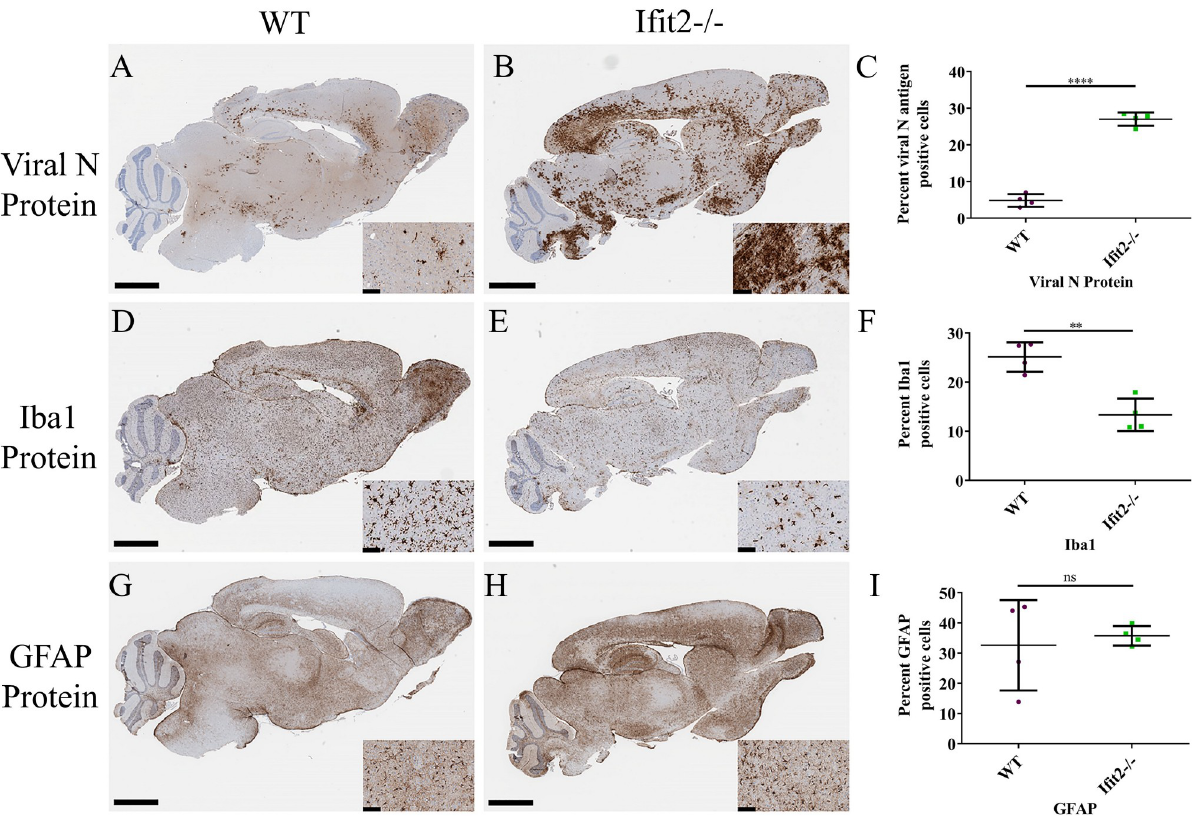
Fig 4. Ifit2 deficiency results in increased viral infection, impaired microglial activation but induce no changes in astrocyte activation upon RSA59 infection. 5 μ m thin serial sections from brain tissues used in Fig 3 were processed for Viral N protein (Panels A,B), Iba1 (Panels D,E) and GFAP (Panels G,H) immunostaining as indicated. Quantification of Viral N protein, Iba1 and GFAP expression are graphically represented in Panel C, F, and I respectively. The experiment was repeated three times and total n = 8.The scale bar for the whole brain section is 2.8 mm and for the insets is 80 μ m. Asterix ( � ) represents differences that are statistically significant by Student’s unpaired t-test analysis. ( �� P < 0.01, ���� P <